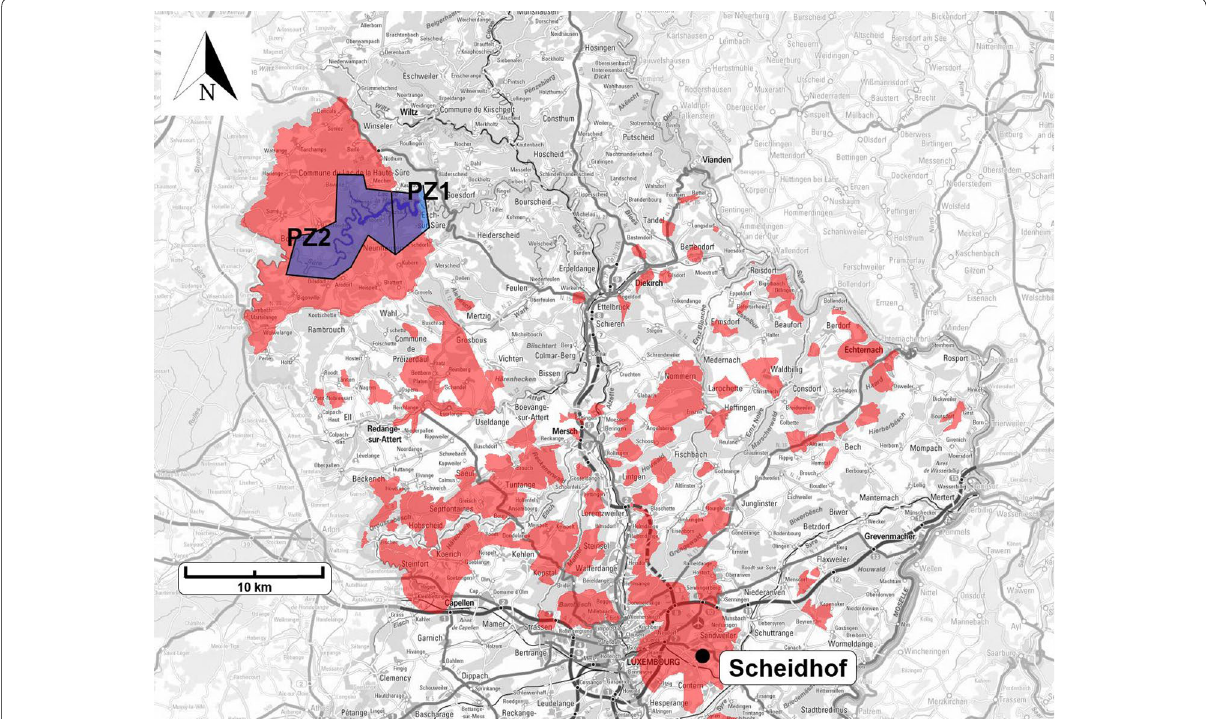
Fig. 4 In blue : representation of the Protection zones 1 and 2 (PZ1 and PZ2) and in red : the areas where the use of metazachlor is